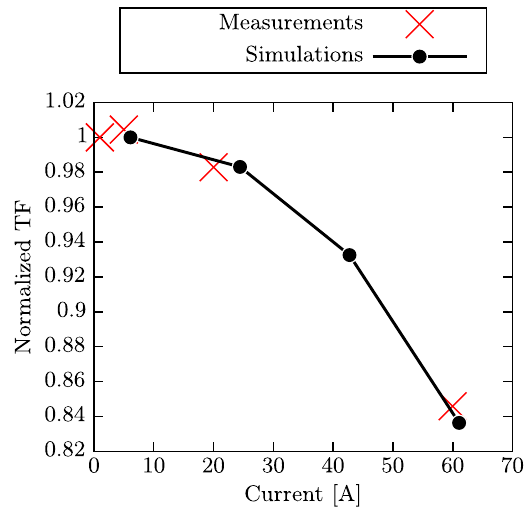
FIG. 13. Comparison of measurement and simulation of the normalized transfer function of a diluted quadrupole with no end plates. Measurements are from [42].